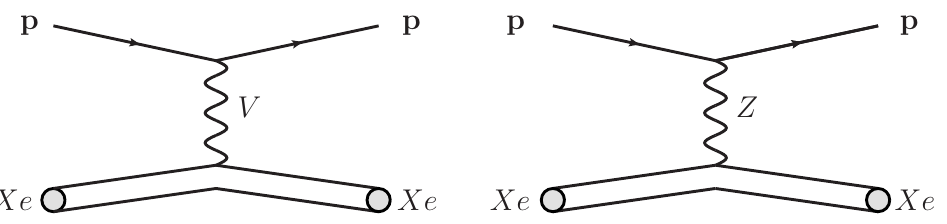
Figure 16: Feynman diagrams contributing to the process of dark matter induced nuclear recoils of